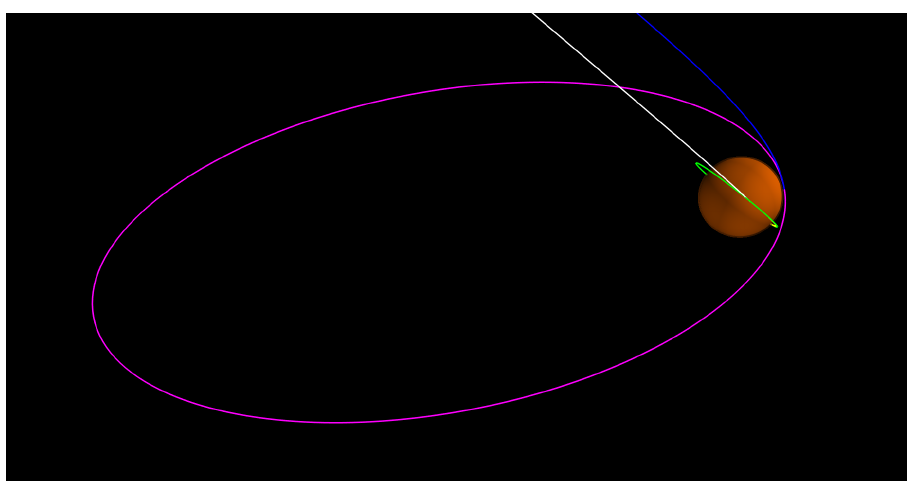
Figure 15. Mars small satellite in 200 × 2000 km near-equatorial orbit post aerocapture (green), and the host orbiter in 250 × 70,000 km polar orbit after propulsive orbit